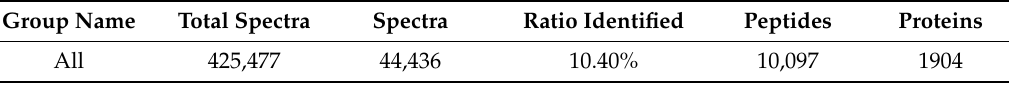
Table 1. Overview of the proteomics sequencing